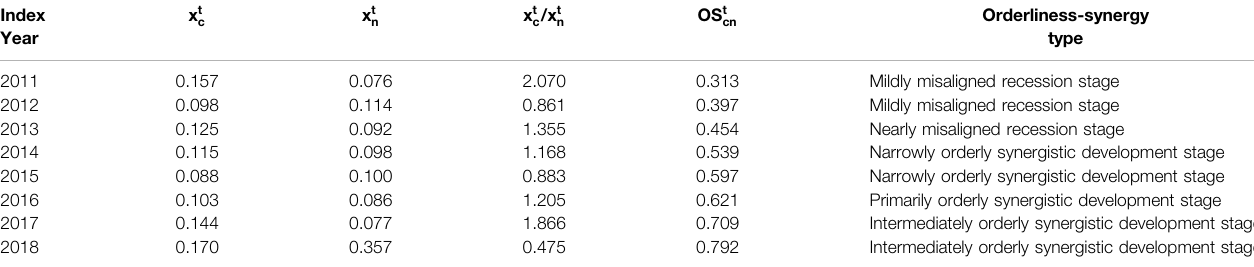
TABLE 4 | Overall level of orderliness synergy between the conventional and the nonconventional in 2011 –